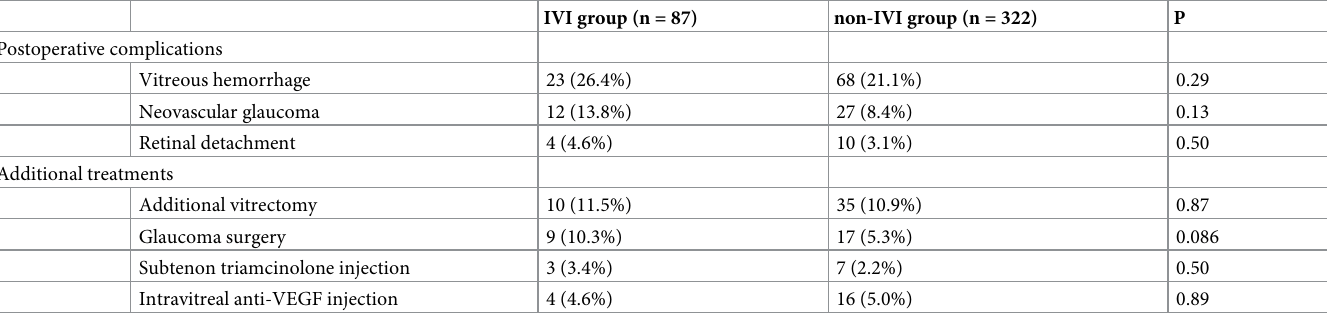
Table 3. Postoperative complications and additional treatments in two groups.